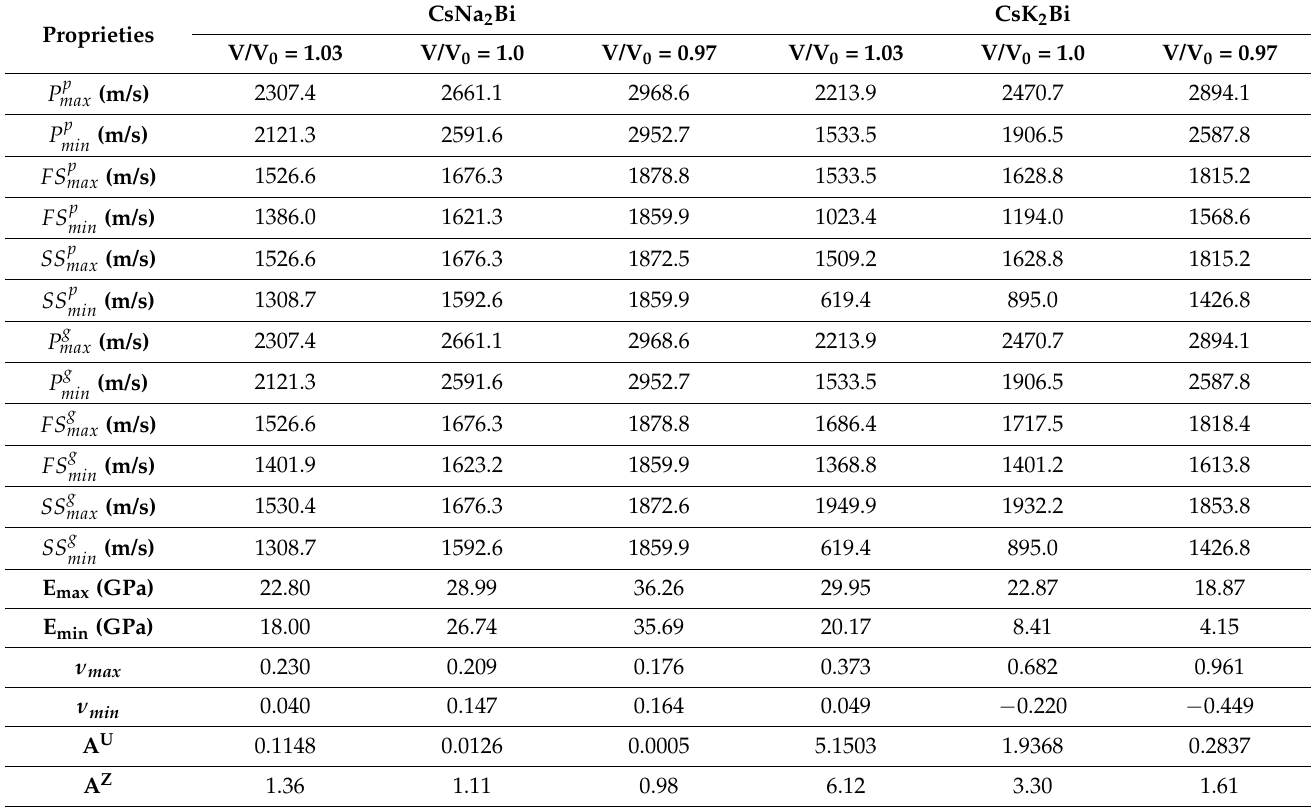
by the elastic anisotropy indices A U and A Z in Table 2. Similar to CsNa 2 Bi, hydrostatic compression (tension) reduces (increases) the degree of anisotropy. Table 2. The minimum (max) and the maximum (min) values of primary mode (P), fast secondary (FS), and slow secondary (SS) of the phase and group velocity, Young’s modulus (E), Poisson’s ratio ( ν ), and anisotropic indexes A U and A Z of Cs(Na, K) 2 Bi under hydrostatic compression (V/V 0 = 0.97), hydrostatic tension (V/V 0 = 1.03), and equilibrium state (V/V 0 =